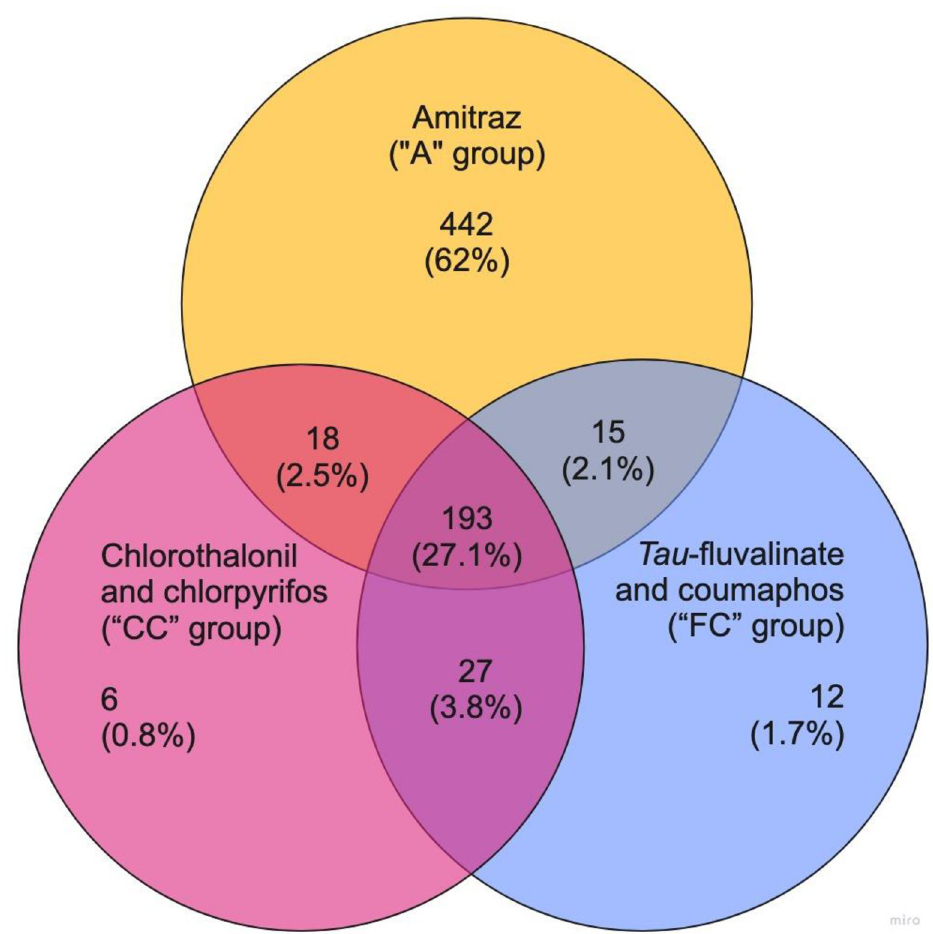
Fig 2. Venn diagram of differentially expressed genes (“DEGs”) across treatment groups. The number (and percentage) inside each circle represents the number of DEGs between the different comparisons (control group versus each treatment group). Each color represents a different comparison: 1) Yellow is amitraz only (“A” group), magenta is chlorothalonil and chlorpyrifos (“CC” group), and 3) blue is tau -fluvalinate and coumaphos (“FC” group). Only annotated genes were considered in these comparisons. The overlapping numbers represent the mutual differentially expressed genes between the different comparisons, while the non-overlapping numbers represent the genes that were unique to each condition. Venn diagram created with the online application